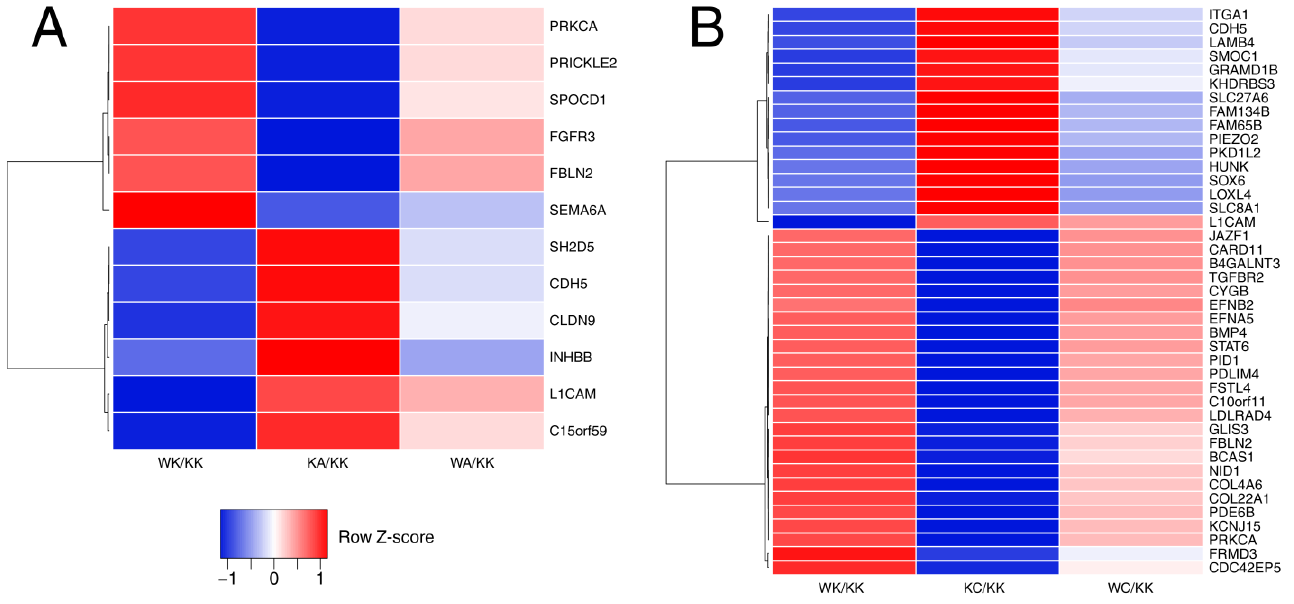
Figure 3. Heatmaps presenting inversely regulated AP-2 targets across ( A ) ‘alpha’ and ( B ) ‘gamma’ comparisons.